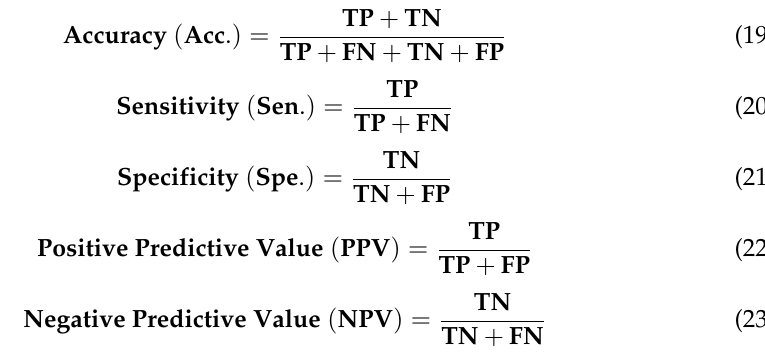
Table 1. Confusion matrix along with the adopted evaluation